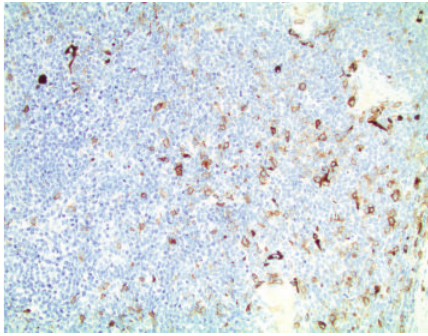
Figure 6: CD117 immunohistochemistry: focal and variable inten- sity of CD117 expression is seen in the blasts (magnification × 400).